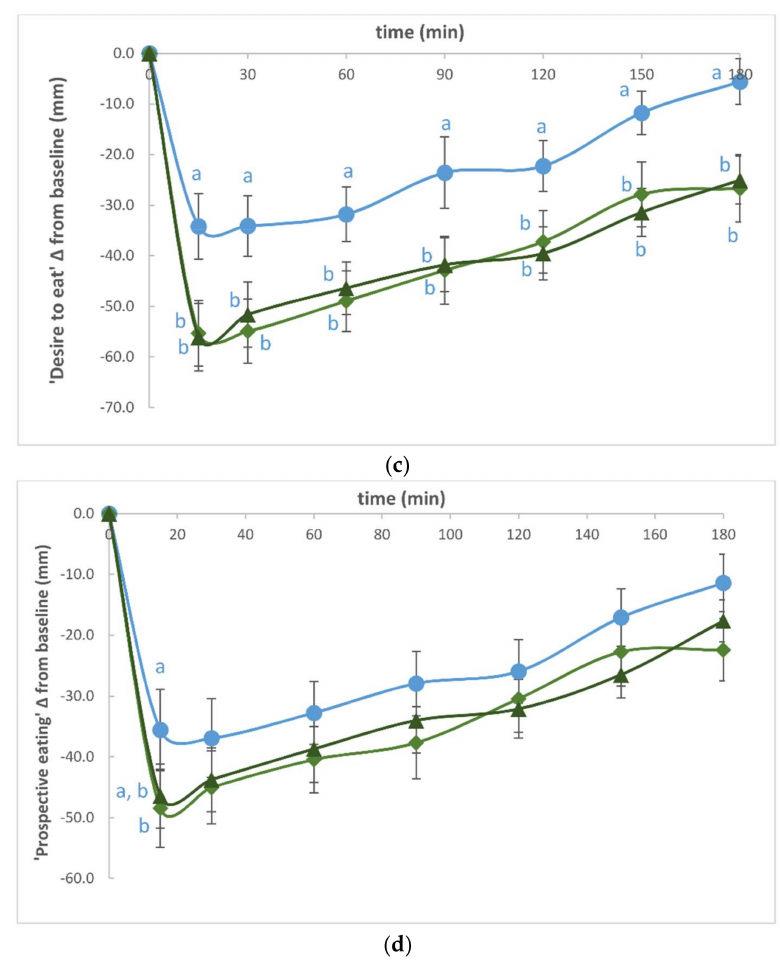
Figure 2. Mean ( ± SEM) in subjective appetite ratings over a 3 h period following consumption of three test meals. ( a ) ‘Hunger’; ( b ) ‘Fullness’; ( c ) ‘Desire to eat’; ( d ) ‘Prospective eating’. Dose 0 Control (D0C), (cid:7) Dose 1 Curry (D1C), (cid:78) Dose 2 Curry (D2C). In all the appetite ratings, the main effect of time and treatment were significantly different ( p -value < 0.05). Treatments that were significantly different from each other ( p -value < 0.05) are represented by different letters at each given time